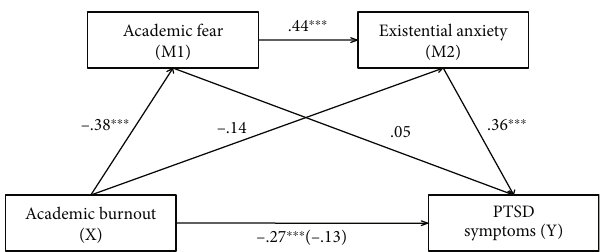
Figure 1: Final results of signi fi cant model for two mediators: academic fear and existential